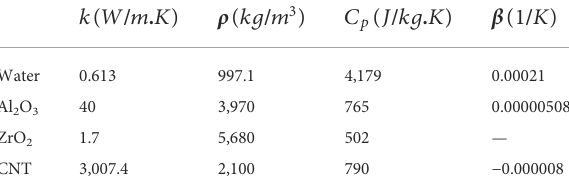
TABLE 1 Investigational values of Al 2 O 3 , ZrO 2 , CNT, and water Arif et al. (2022). k ( W / m . K )